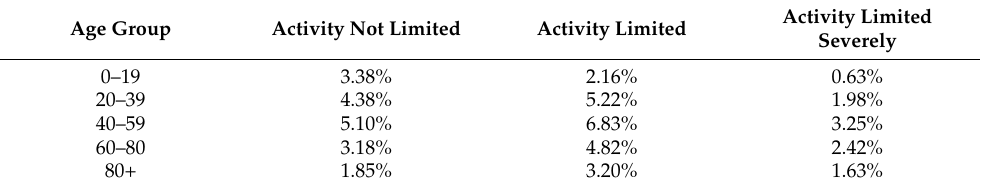
Table A4. (a) Population counts per age group and category based on raw data from the Dutch